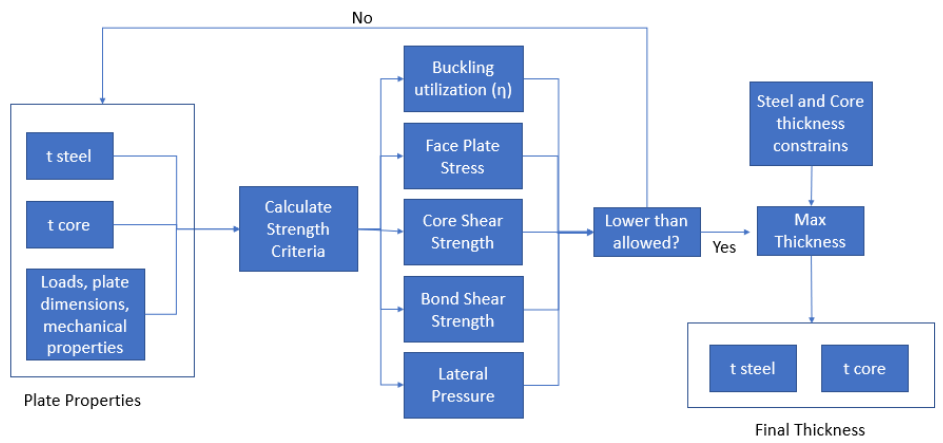
Figure 6. Flowchart to design the SPS panel.